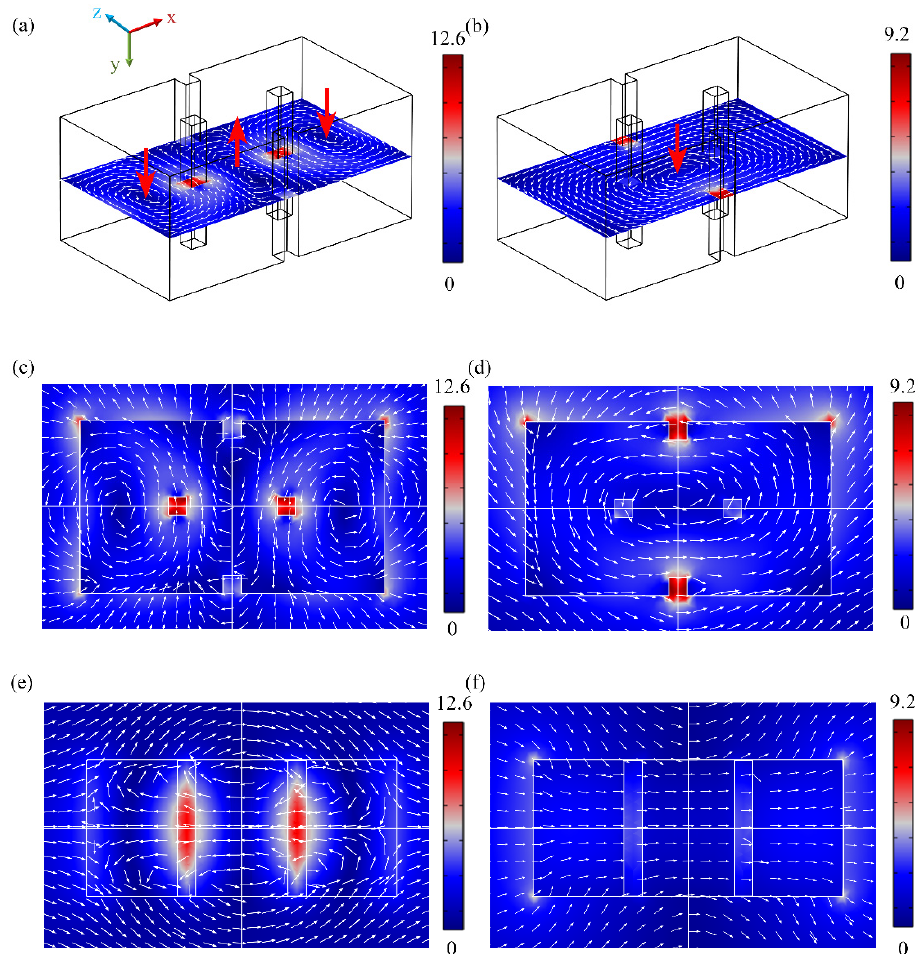
Figure 4. ( a , b ) Electromagnetic resonance modes in the OH-SiNB cavity at λ 1 = 800 nm and λ 2 = 1190 nm, respectively; the red arrows indicate magnetic vector field. Electric-field ( | E |/| E 0 |) distribution in the ( c ) xoz plane and ( e ) xoy plane at λ 1 = 800 nm. Electric-field distribution in the ( d ) xoz plane and ( f ) xoy plane at λ 2 = 1190